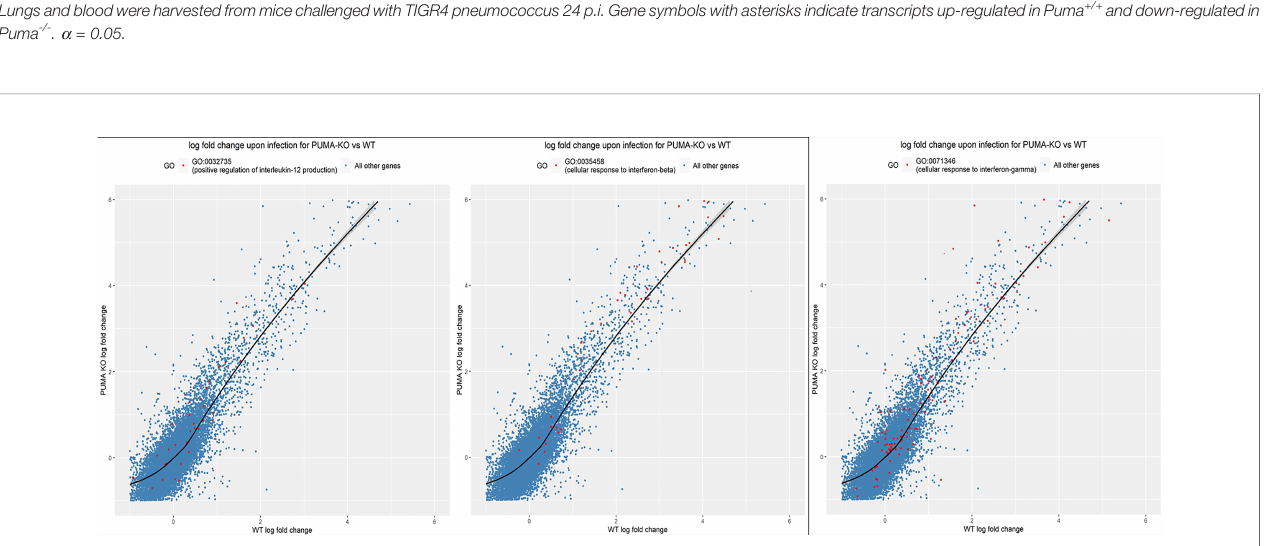
FIGURE 4 | Gene ontology analysis reveals Puma limits IL-12 and Type I and II IFN signaling. Genes signi fi cantly expressed (red dots) in their respective GO groups are plotted against all other genes (blue dots). Signi fi cance was determined using the Kolmogorov-Smirnov test and p-values were adjusted for multiple-testing. The area above the black line indicates higher expression in Puma -/- mice, while the area under the black line indicates higher expression in Puma +/+